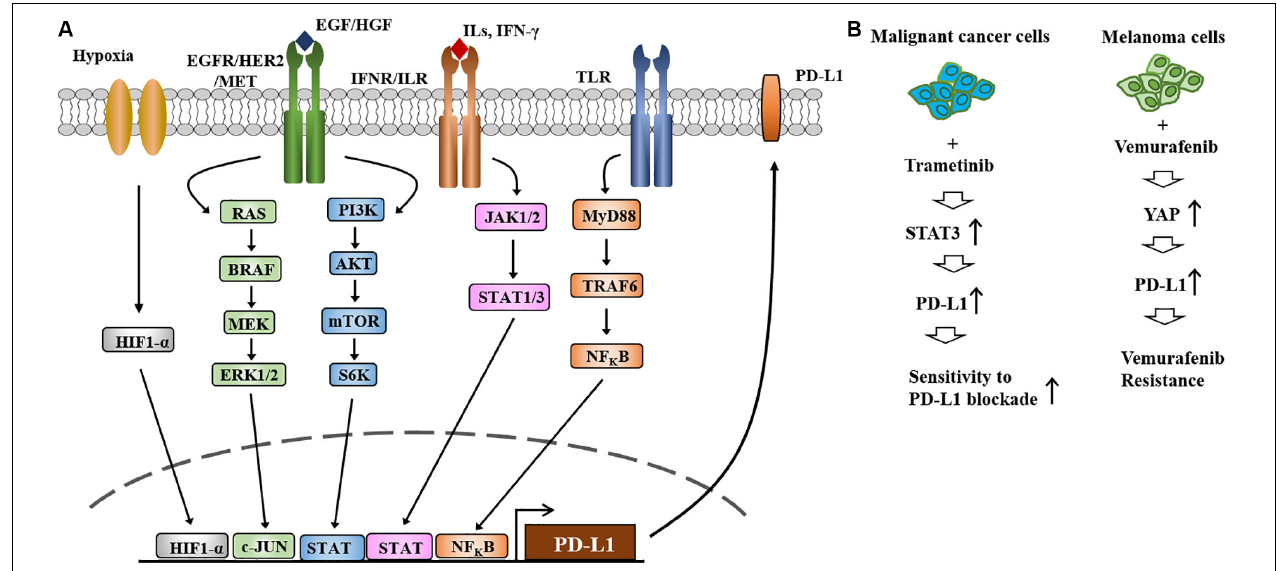
FIGURE 4 | The expression and regulation of PD-L1and the role of PD-L1 in anti-cancer drug resistance. (A) Regulation of PD-L1 expression occurs at different levels. HIF-1 α directly increases the expression of PD-L1 by binding to the promoter sequences of PD-L1. Toll-like receptor signaling increases the expression of PD-L1 by NF-kB. PI3K/AKT/mTOR and RAS/RAF/MEK/ERK signaling increase the expression of PD-L1 by activating C-Jun and STAT3. JAK/STAT signaling activated by IFN- γ increases the expression of PD-L1. (B) Treatment of metastatic melanomas with BRAF inhibitors or a combination of BRAF/MEK inhibitors leads to immune evasion (left). Increased expression of PD-L1 increases resistance to MEK inhibitors and EGFR-TKIs (left). MEKi denotes MEK inhibitor. EGFR-TKIs denote EGFR-tyrosine kinase inhibitors. Repeated exposure to vemurafenib increases the expression level of PD-L1, which in turn confers resistance to vemurafenib